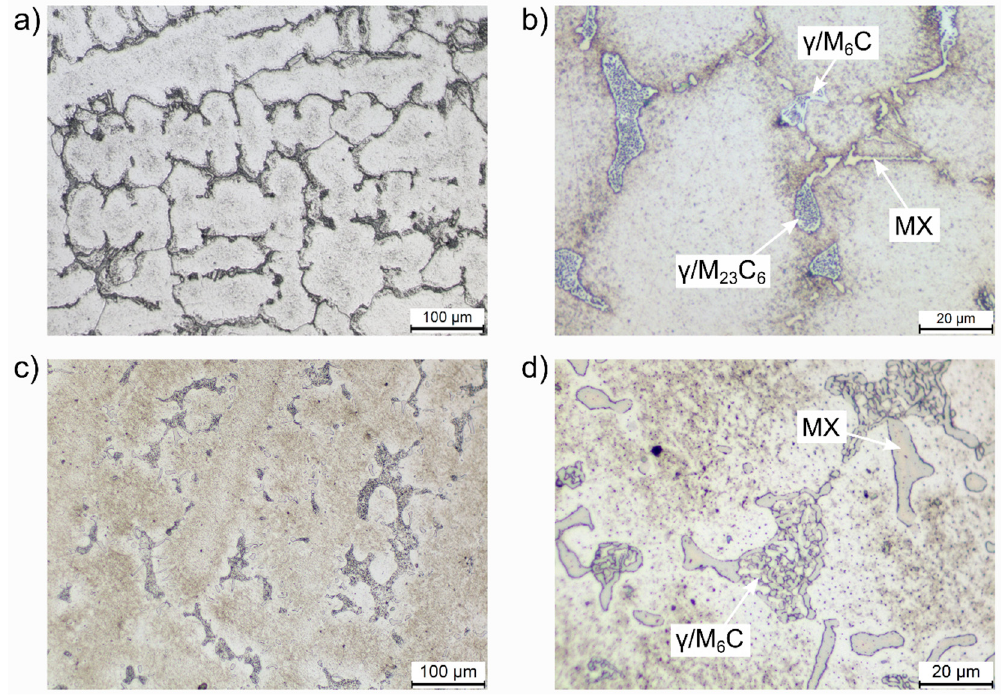
Figure 3. Optical micrographs of the steel 1.4957 ( a , b ) and 5Mo-2W ( c , d ) in different magnifications.